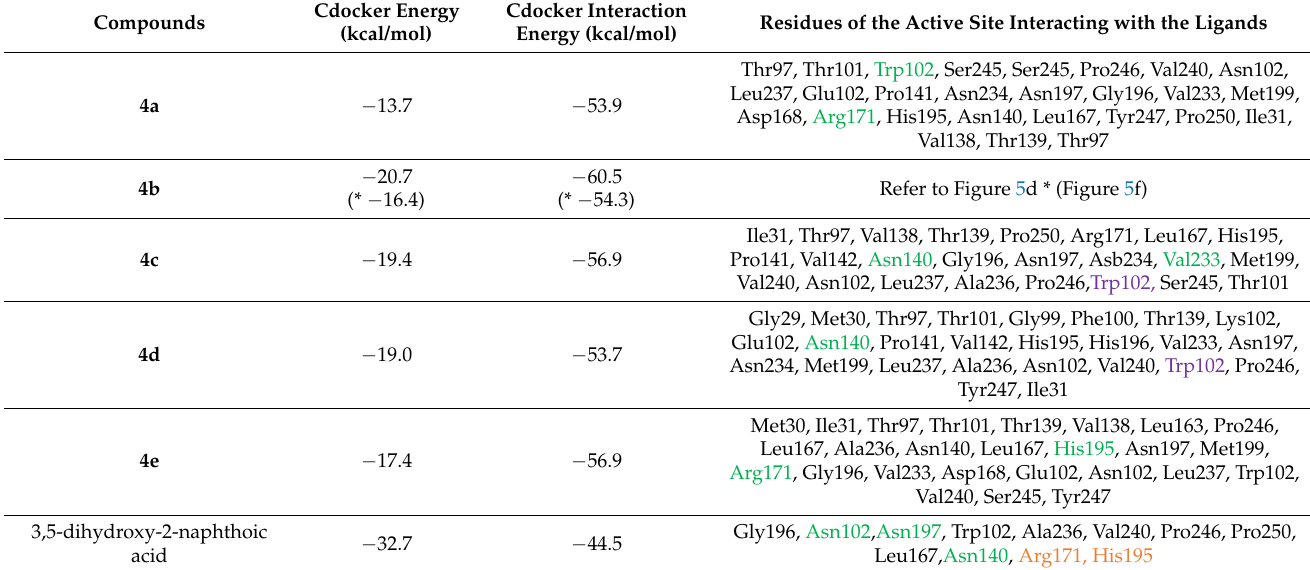
Table 2. Docking results for compounds 4a – e and 3,5-dihydroxy-2-naphthoic acid in the active site of PfLDH.